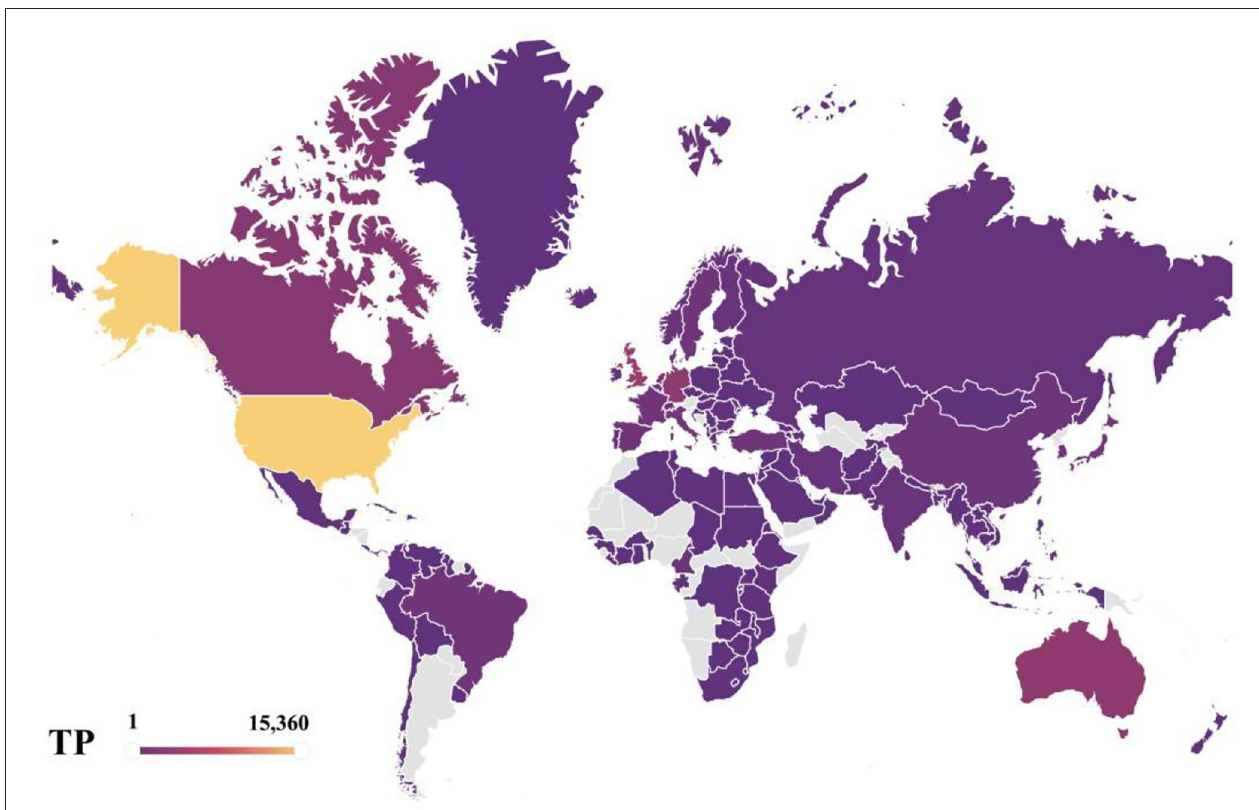
FIGURE 1 | Geographical distributions of publications, 2004–2019.